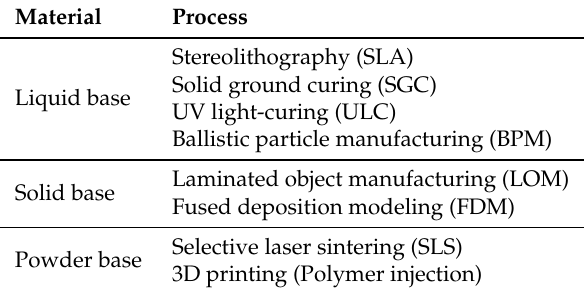
Table 1. Rapid prototyping techniques available for